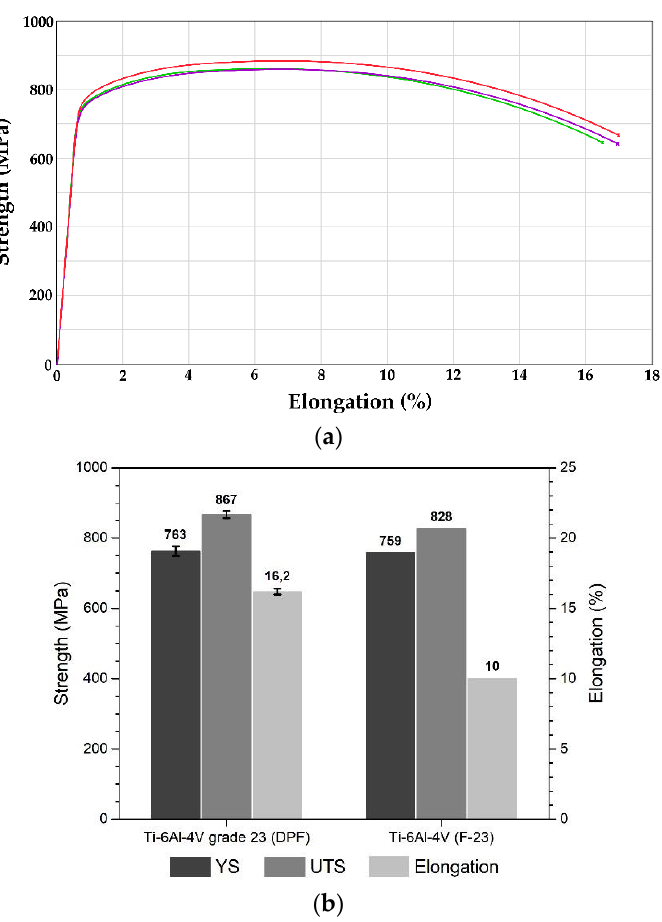
Figure 9. Mechanical properties of annealed Ti-6Al-4V DPF . Representative stress-strain curves are presented in ( a ) and the averages for YS, UTS and elongation compared to the standard requirement (grade F23) are presented in ( b ).